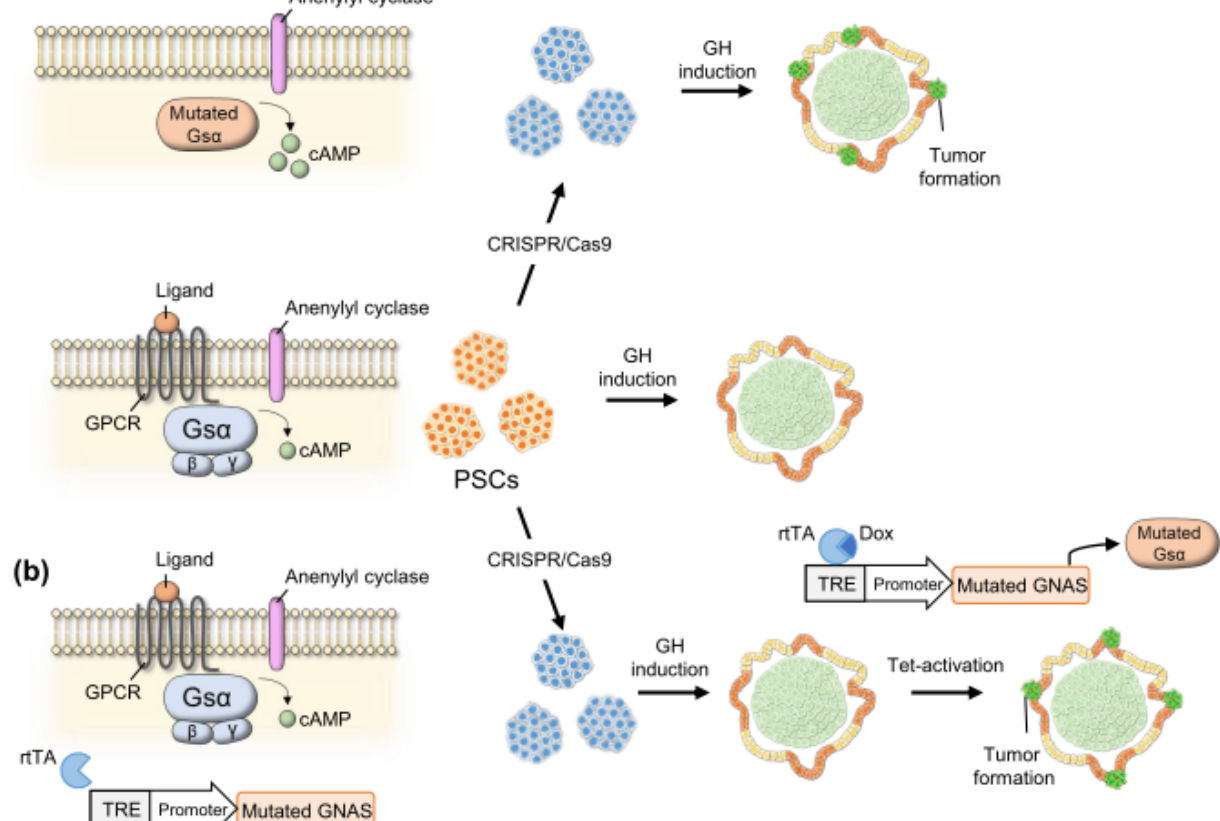
Figure 4. Schema of strategies to establish in vitro growth hormone (GH)-producing adenoma (GHoma) model. ( a ) A gain-of-function mutation is introduced into human pluripotent stem cells (hPSCs) at the guanine nucleotide-binding protein G(s) subunit alpha ( GNAS ) locus. The mutation activates Gs α and its effector adenylate cyclase, autonomously synthesizing cAMP. Induction into GH-producing cells from the hPSCs might form a GHoma-like tumor. ( b ) Inducible expression cassette (ex. tetracycline-inducible expression system) of Gs α active form is introduced in hPSCs, while leaving endogenous GNAS locus intact. After induction into GH-producing cells, Gs α active form expression is induced, which might form a GHoma-like tumor.